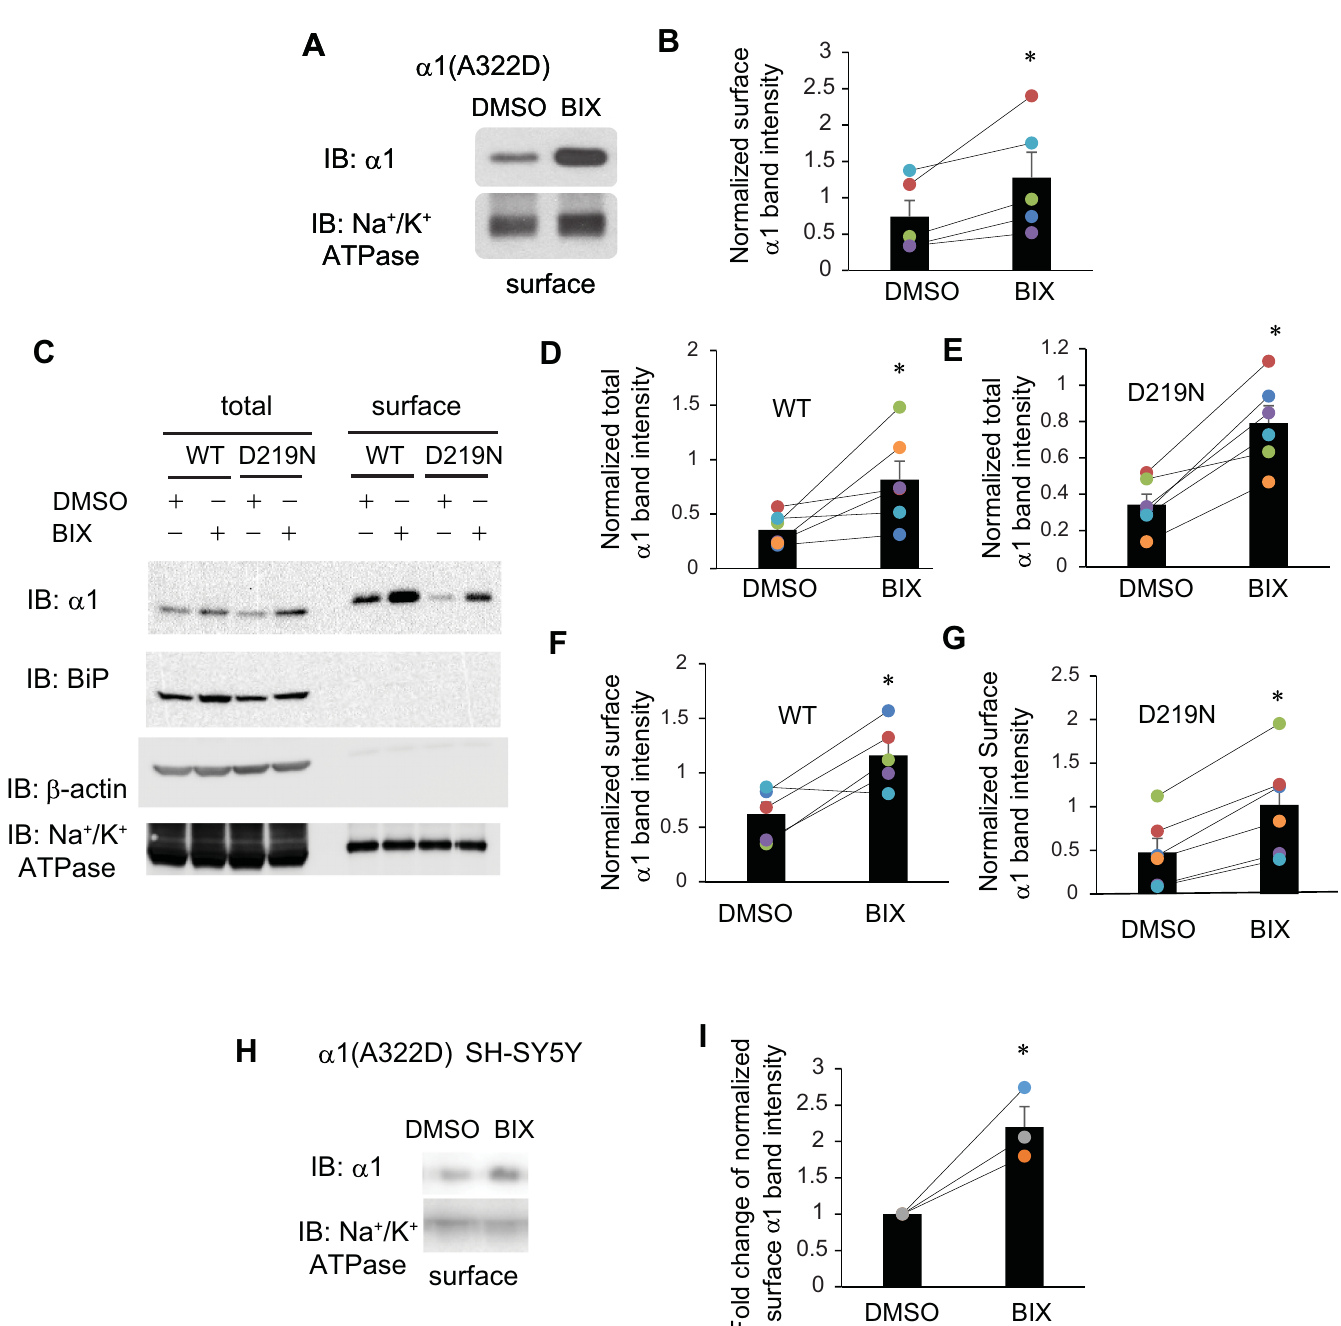
Fig 3. BIX enhances the surface expression of α 1 subunit variants of GABA A receptors. ( A ) HEK293T cells expressing α 1(A322D) β 2 γ 2 receptors were treated with BIX (12 μ M, 24 h) or DMSO vehicle control. Then the cell surface proteins were tagged with biotin using membrane-impermeable biotinylation reagent sulfo-NHS SS-Biotin. Biotinylated surface proteins were affinity-purified using neutravidin-conjugated beads and then subjected to SDS-PAGE and Western blot analysis. The Na + /K + -ATPase serves as a surface protein loading control. Quantification of normalized surface α 1(A322D) protein levels to the Na + /K + -ATPase controls is shown in ( B ) (n = 5, paired t-test). ( C ) HEK293T cells expressing α 1 β 2 γ 2receptors or α 1(D219N) β 2 γ 2receptors were treated as in ( A ). Quantification of normalized total and surface WT α 1 protein levels is shown in ( D & F ) (n = 6 for total and n = 5 for surface, paired t-test). Quantification of normalized total and surface α 1(D219N) protein levels is shown in ( E & G ) (n = 6 for total and surface, paired t-test). ( H ) SH-SY5Y cells stably expressing α 1(A322D) β 2 γ 2 receptors were treated with BIX (12 μ M, 24 h) or DMSO vehicle control. Then surface biotinylation assay was performed as in ( A ). Quantification of normalized surface α 1(A322D) protein levels is shown in ( I ) (n = 3, two tailed student t-test). � p <